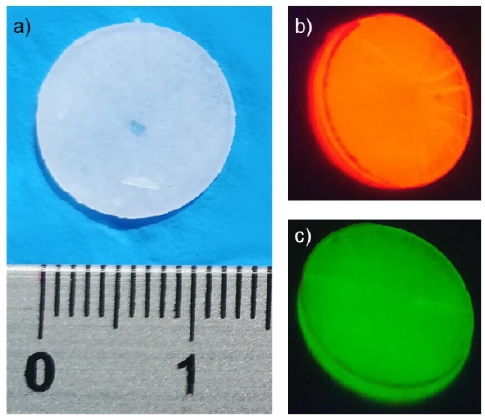
Figure 2. ( a ) Picture of a pellet illuminated with white light (the length scale is in cm); and ( b , c ) picture of KBr pellets containing 1 ( b ) and 2 ( c ) exposed to UV light ( λ exc =320 nm) at room temperature.